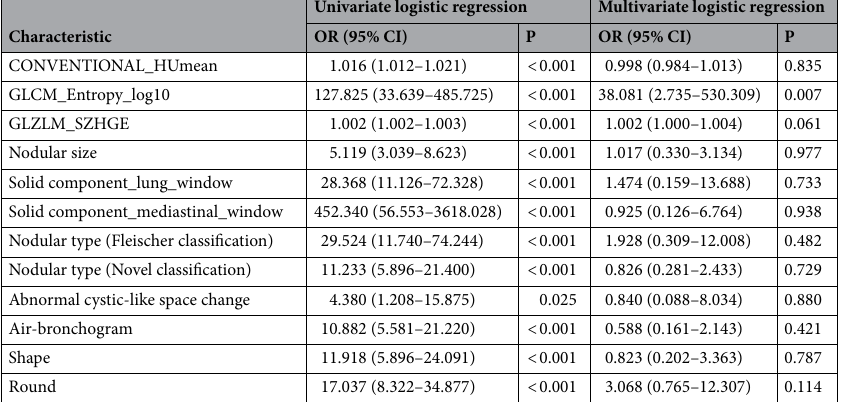
Table 3. Univariate and multivariate logistic regression model to differentiate invasive lesions from preinvasive lesions. HU hounsfield unit, GLCM gray-level co-occurrence matrix, OR odds ratio, GLZLM grey- level zone length matrix, SZHGE short-zone high grey-level